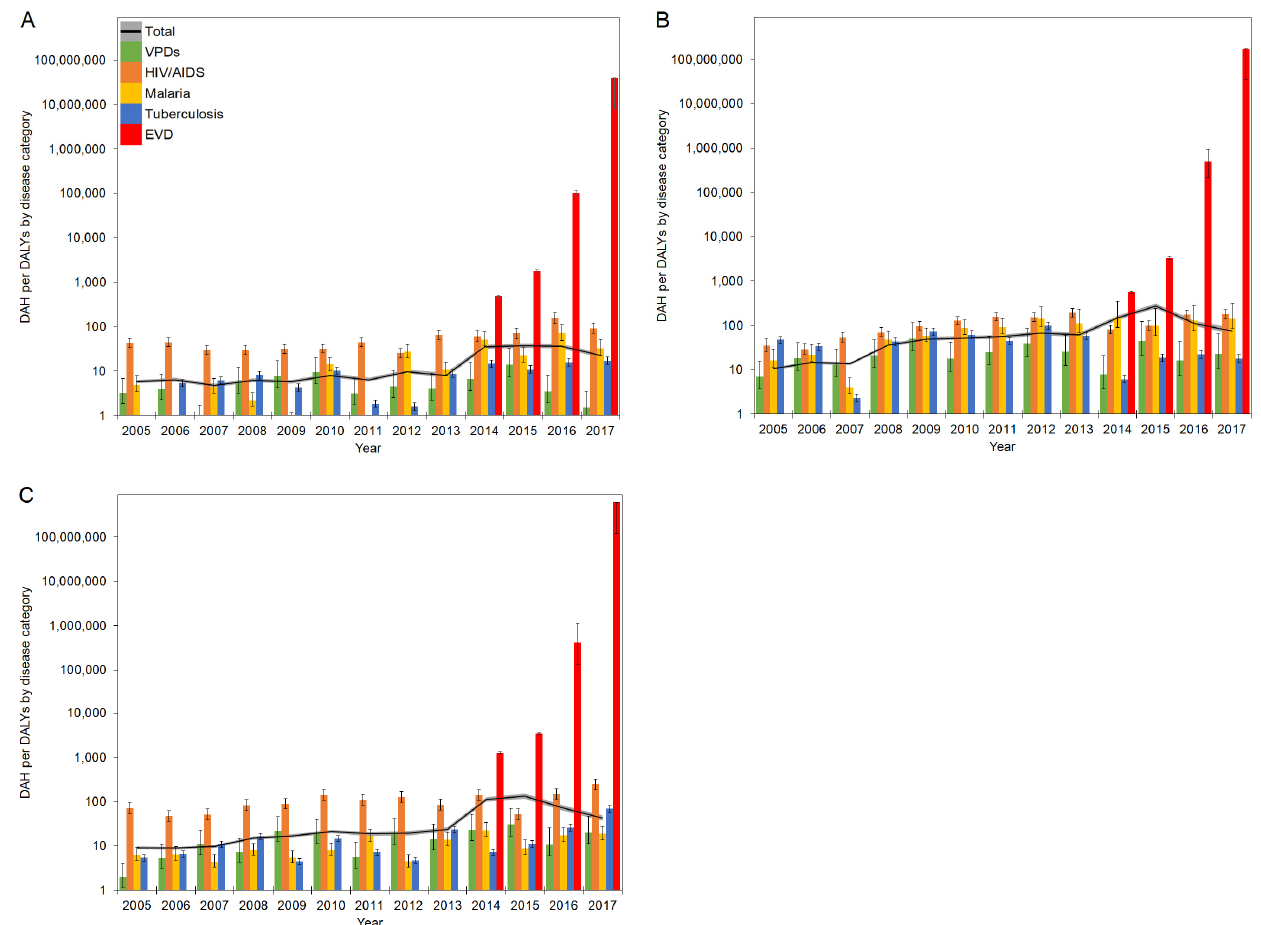
Figure 4. DAH/DALYs in countries in West Africa in 2005–2017: ( A ) Guinea; ( B ) Liberia; ( C ) Sierra Leone. The black line represents the total DAH/DALYs, and the gray area is extended to the upper and lower 95% confidence intervals based on variations of DALYs. Colored bars represent the DAH/DALYs by disease category. Whiskers extend to the upper and lower 95% confidence intervals based on variations of DALYs. A common logarithmic scale is used on the vertical axis.